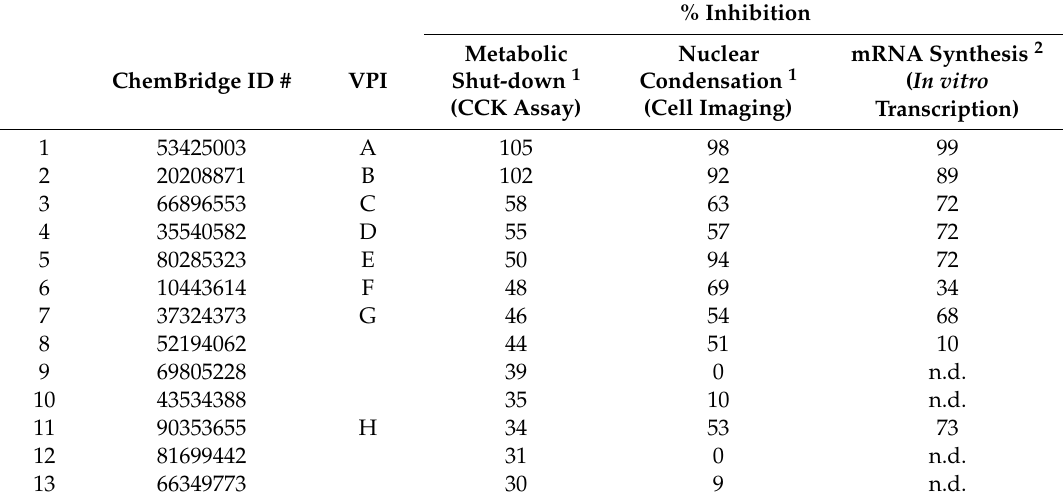
Table 1. Results of primary screening for anti-VSV